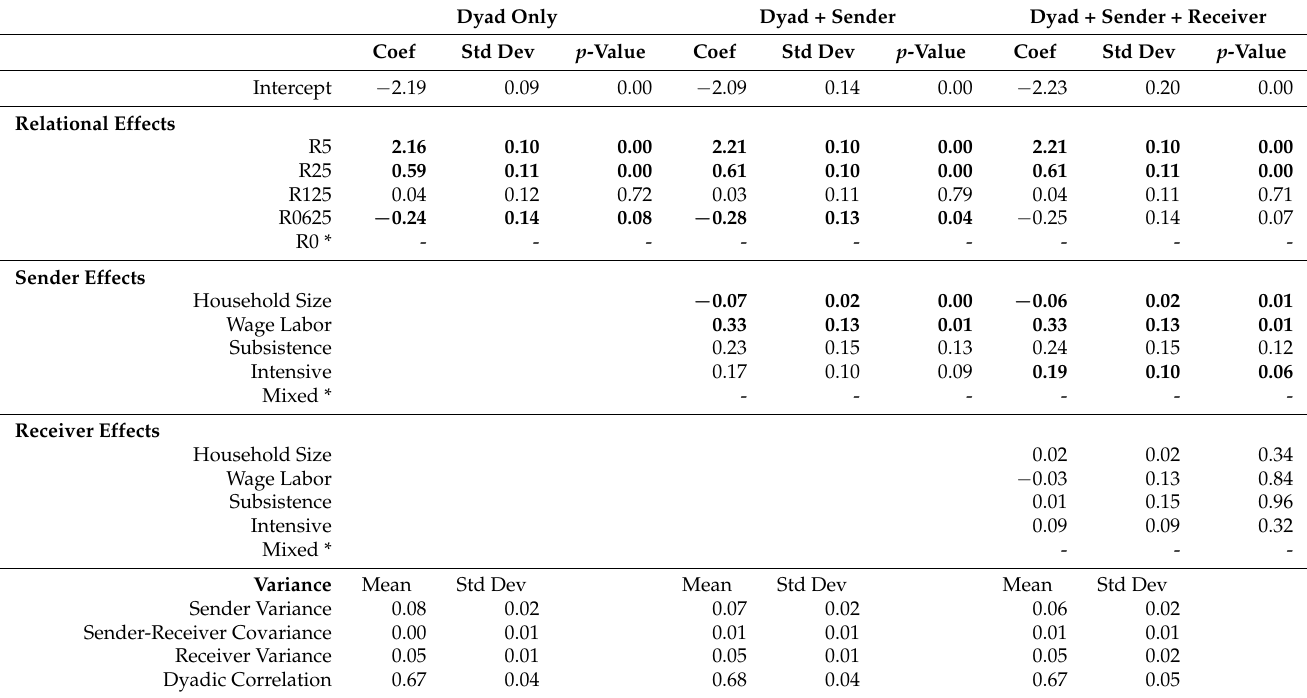
Table 2. Social Relations Model